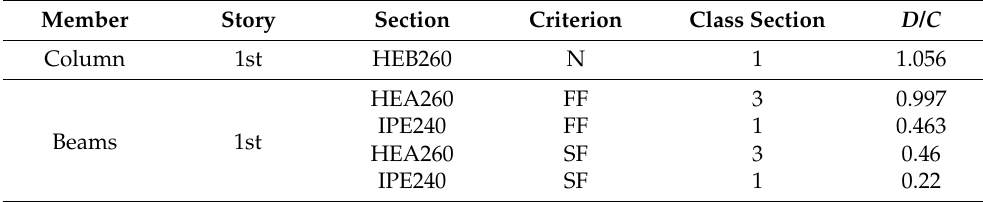
Table 9. Maximum demand-to-capacity ratios for steel members under gravitational loads.